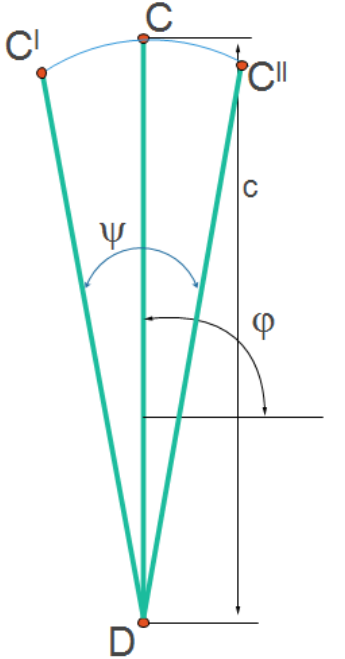
Figure 5. Representation of the angle made by the tie rod. − The coordinates for the fixed point F (respectively x F and y F —the element representing the fixed end of the tie rod) can be determined using